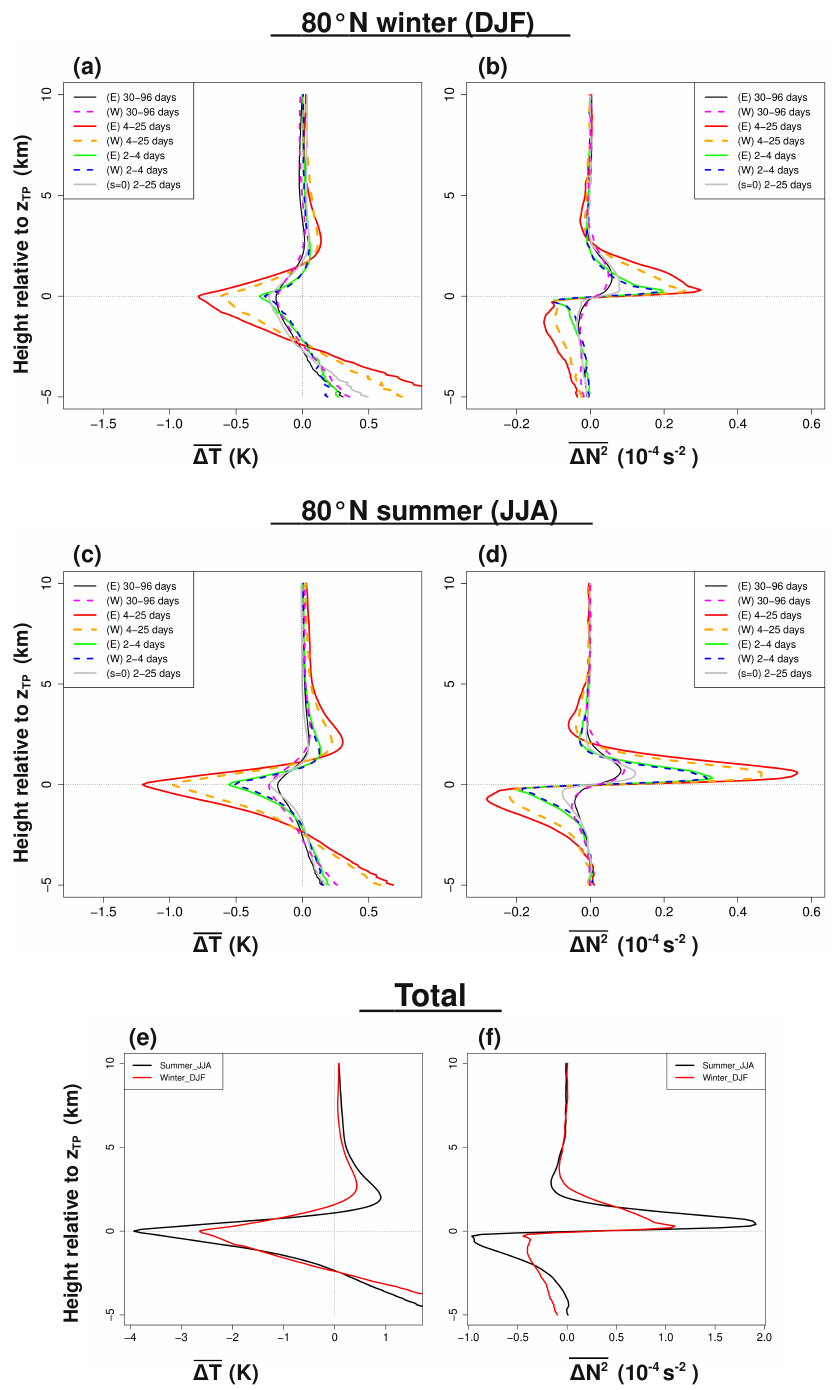
Figure 6. As in Fig. 4, but for 80 ◦ N.